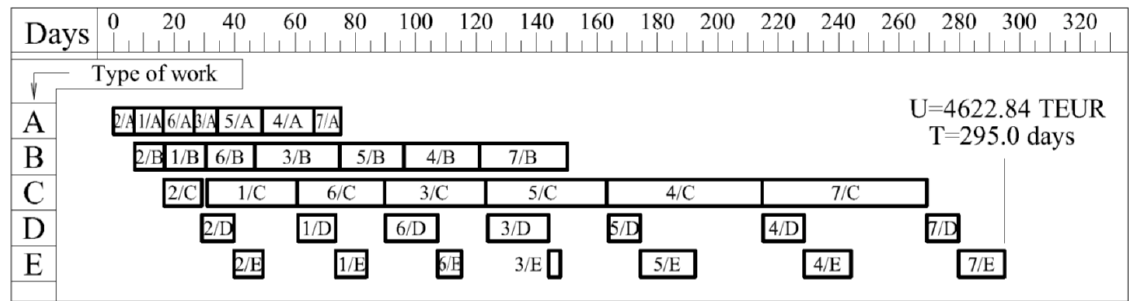
Figure 5. Permutation π SA —optimized construction project schedule.